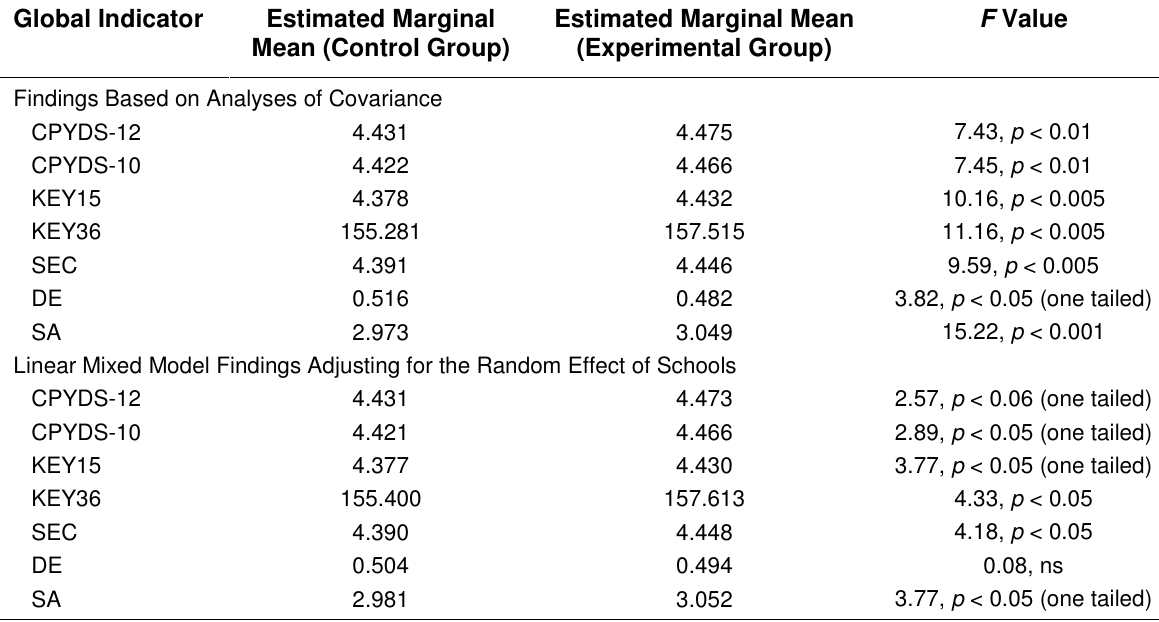
Differences between the Experimental (Joining the Tier 1 Program Only) and Control Group based on the Different Indicators Derived from the Chinese Positive Youth Development Scale Global Indicator Findings Based on Analyses of